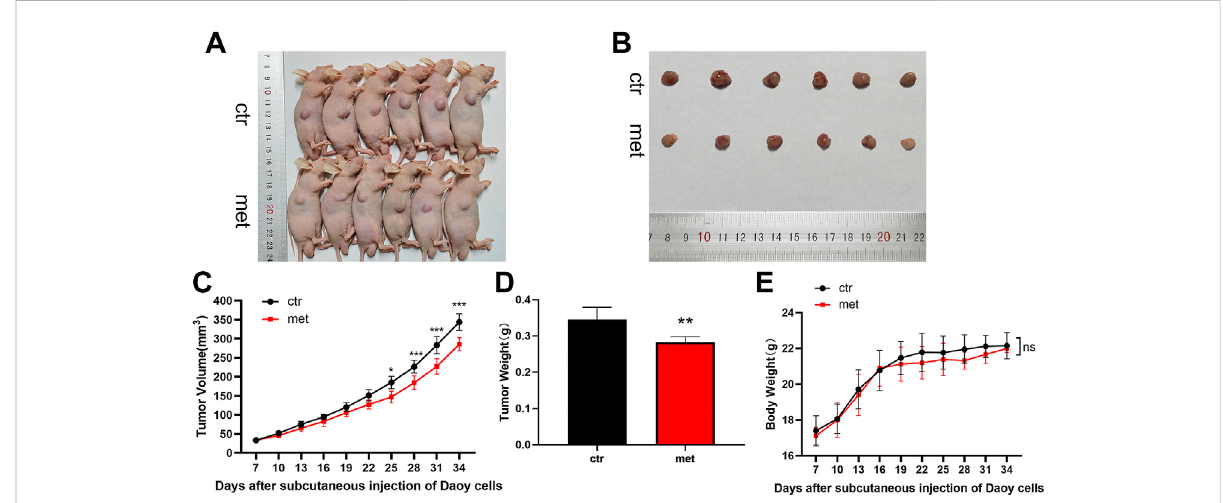
FIGURE 8 Metformin resisted Shh subgroup MB growth in vivo . (A) Photo of the nude mice bearing subcutaneous xenograft tumor. (B) Photo of tumors removed from mice after 24 days of metformin (200 mg/kg) or PBS treatment. (C) Tumor volume was recorded every 3 days (D) The weight of the excised tumor tissue. (E) Body weight of mice was recorded every 3 days ( n = 6). Data are presented as the mean ± SD, two-way ANOVA multiple comparisons were used to determine the signi fi cance. * p < 0.05; ** p < 0.01; *** p < 0.001 compared with the control